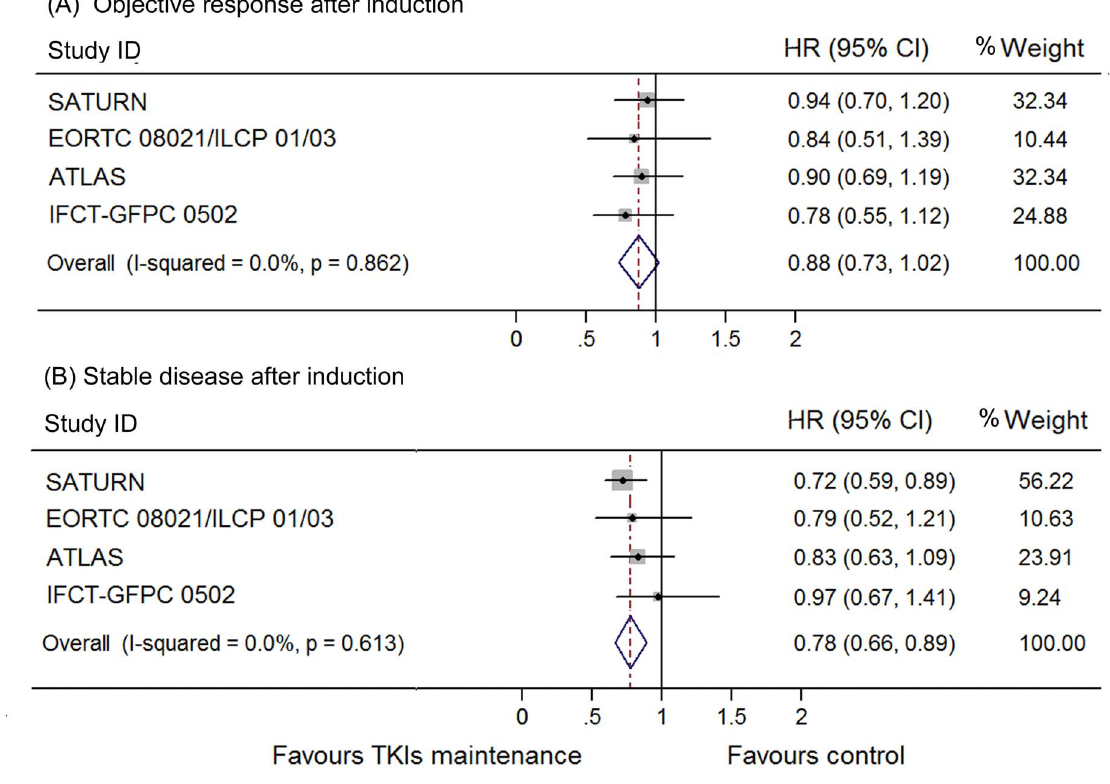
Figure 7. Meta-analysis of hazard ratio (HR) for overall survival (OS) according to previous response to induction chemotherapy. (A) Objective response after induction. (B) Stable disease after induction. doi:10.1371/journal.pone.0059314.g007 PLOS ONE |